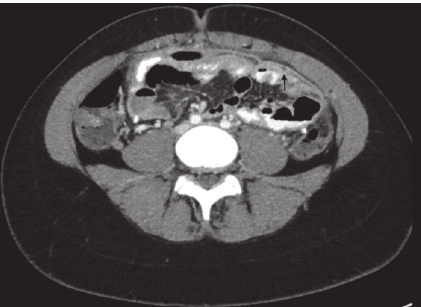
Figure 1: Peritonitis due to NVS. Abdominal CT scan with contrast. The arrow points to the hyperintensity demonstrating fluid accumu- lation consistent with peritonitis.